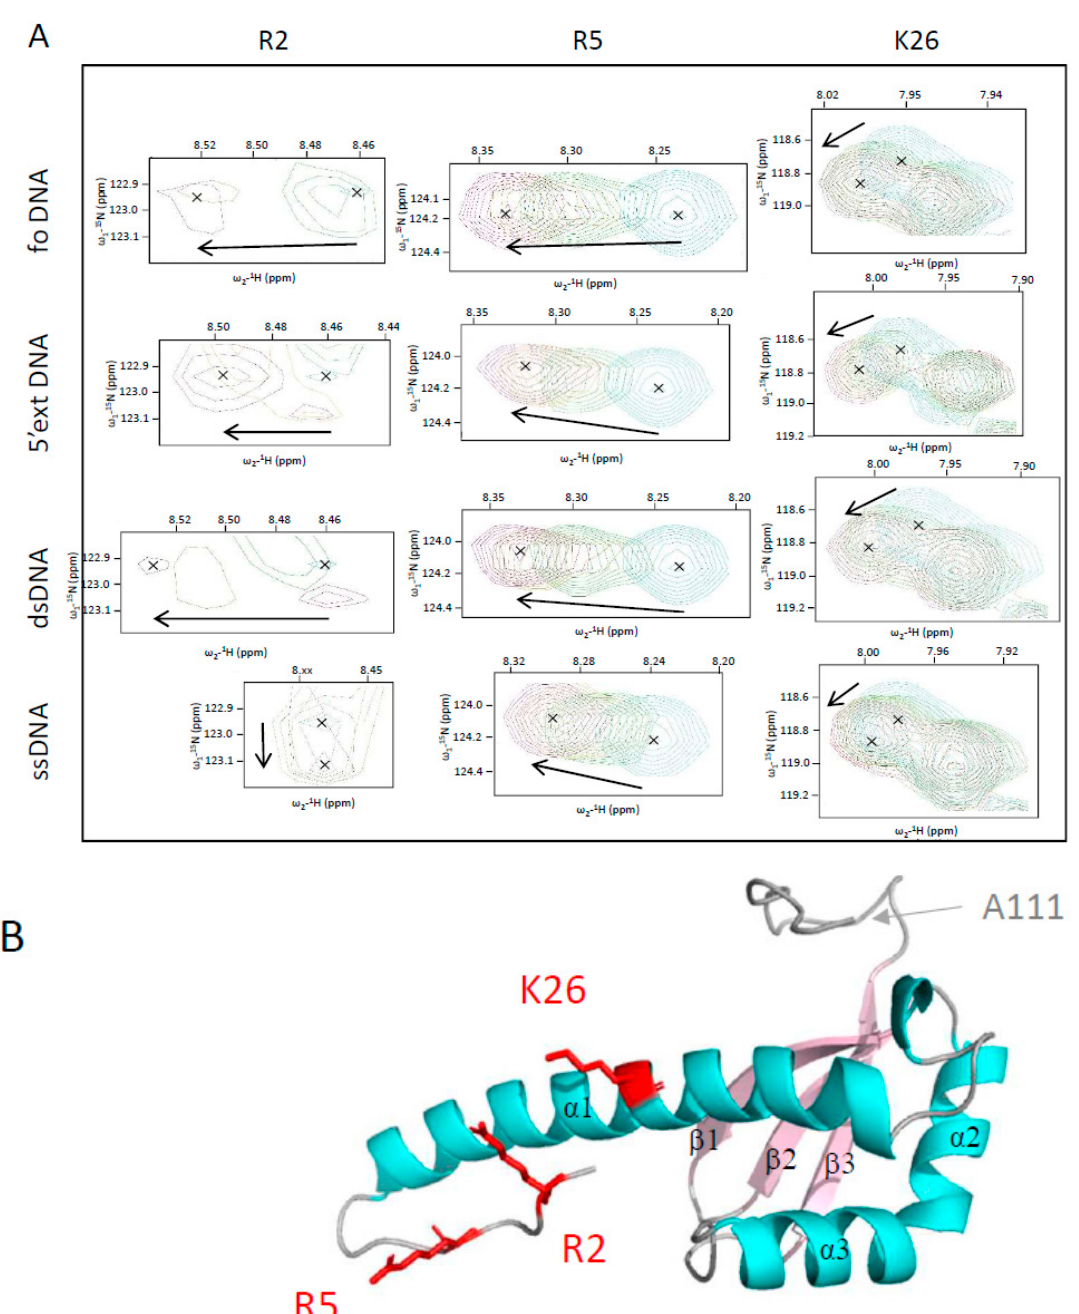
Figure 4. The long α -helix 1 of Vc DciA interacts with the four DNA substrates as identified by NMR. ( A ) Chemical shifts of R2, R5, and K26 residues of Vc DciA alone and after addition of DNA. Peak enlargements of the three residues were extracted from the spectra of Vc DciA titrated with forked (foDNA NMR ), 5 (cid:48) -extDNA (free 5 (cid:48) end), double-stranded (dsDNA NMR ), and single-stranded (ssDNA NMR ) DNA (Table 1). Sofast-HMQC spectra were recorded at protein–DNA ratios of 1:0, 1:0.5, 1:1, and 1:2 molar ratios (cyan, yellow, red, and purple, respectively). Increasing the amount of DNA caused the peaks of the 3 residues to shift. The centers of the peaks are marked with X, and an arrow marks their shifts. The interaction of R2 with DNA also induced signal attenuation. ( B ) Schematic representation of Vc DciA [1–111] . The α -helices are in cyan and the β -strands are in pink. Residues selected to generate mutated versions of Vc DciA are indicated on the structure of Vc DciA [1–111] . The lateral chains of the R2, R5, and K26 residues are shown in red sticks. They were mutated in aspartic acids in order to validate their impact on Vc DciA binding to DNA and on the helicase